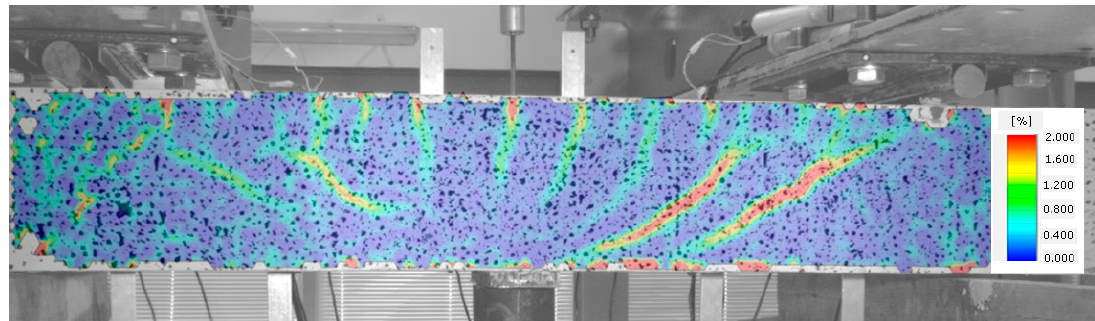
Figure 11. Stage III of shear behavior of element—occurrence of diagonal cracks in both shear areas.